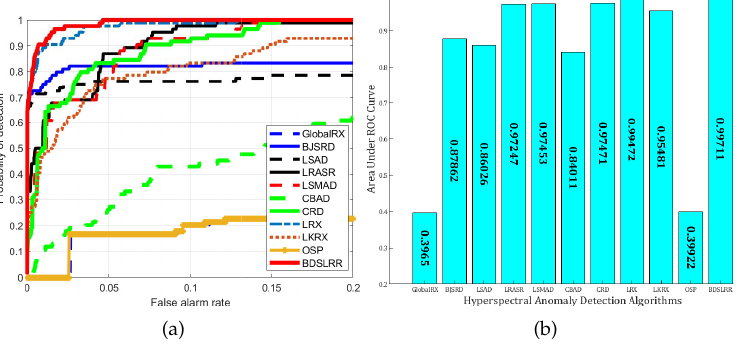
Figure 11. Detection accuracy evaluation for the synthetic dataset. ( a ) ROC curves; ( b ) AUC values.